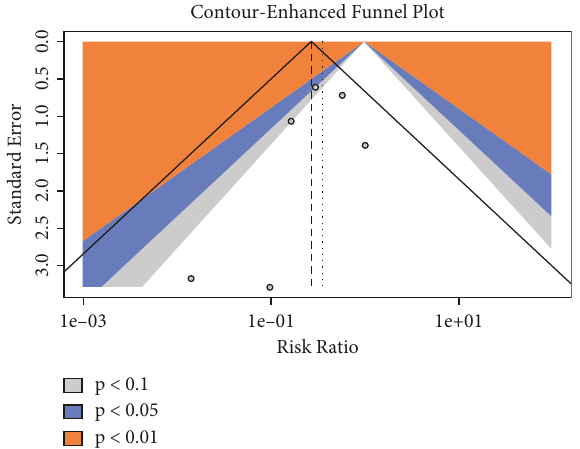
Figure 5: Funnel plot for publication bias of ventricular arrhythmias.